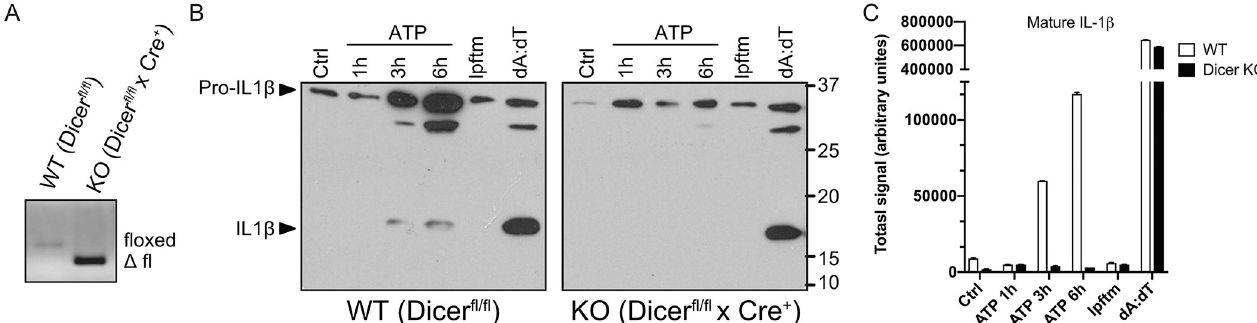
Fig 1. Dicer is required for optimal secretion of mature IL-1 β following stimulation of the NLRP3 but not the AIM2 inflammasome. ( A ) Deletion of the floxed allele from day 7 bone marrow macrophages prepared from Dicer fl/fl x ER T -Cre - (WT) or Dicer fl/fl x ER T -Cre + (KO) mice was confirmed by PCR. ( B ) Dicerfl/fl x ERT-Cre- (WT) or Dicerfl/fl x ERT-Cre+ (KO) BMMs were primed with 1 μ g/ml LPS for 4 h (signal 1) before stimulation with 5 mM ATP for 1, 3 or 6 hours or transfected (lipofectamine; lpftm) with 1 μ g/ml poly dA:dT (dA:dT) for 6 hours (signal 2). Secreted IL-1 β levels were then evaluated by immunoblotting. Arrows indicate the immature form of IL-1 β (pro-IL1 β ) and the mature secreted form (IL-1 β ). ( C ) Quantitative analysis of the mature secreted form of IL-1 β shown in panel B.